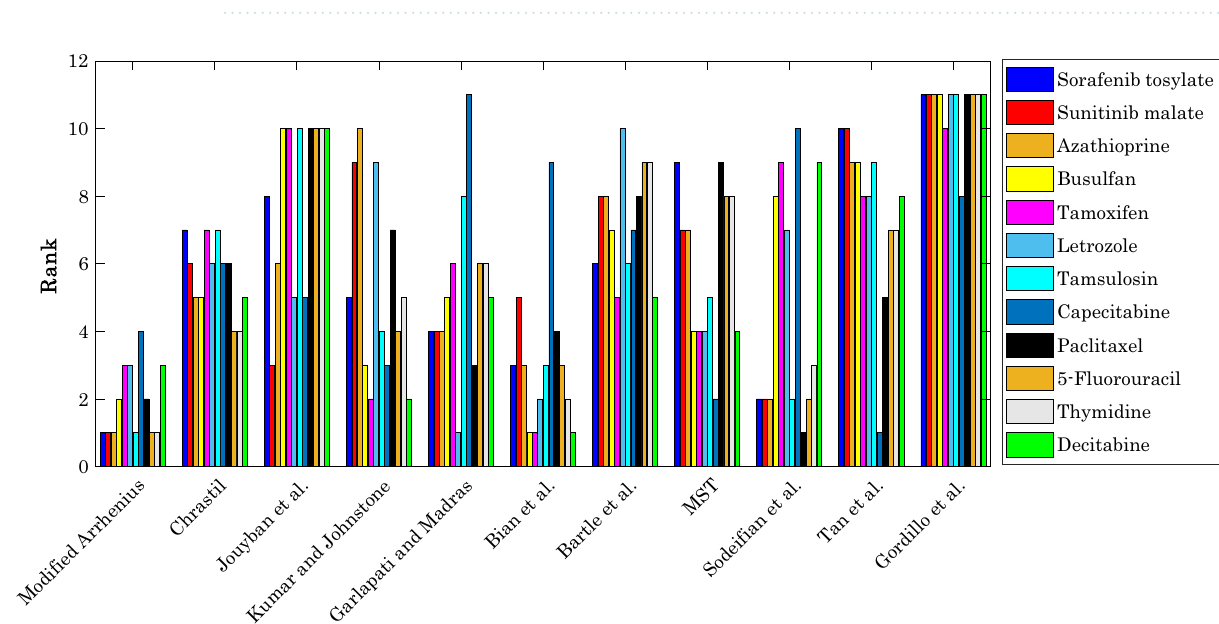
Figure 5. Outcome of the ranking analysis on the accuracy of the developed correlation and those available in the